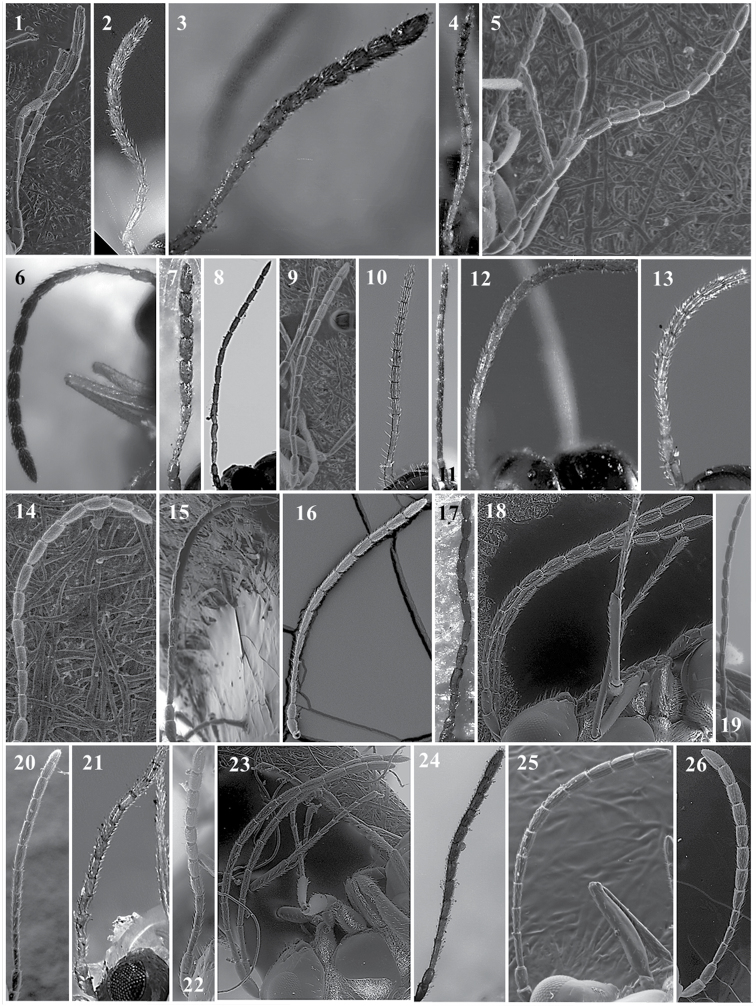
Alloxysta antennae. A.fracticornis (1); A.fuscipes (2); A.glebaria (3); A.halterata (4); A.hansoni (5); A.hendrickxi (6); A.heptatoma (7); A.japonicus (8); A.kovilovica (9); A.lachni (10); A.leunisii (11); A.longipennis (12); A.longiventris (13); A.luismii (14); A.macrophadnus (15); A.mara (16); A.marshalliana (17); A.medinae (18); A.mexicana (19); A.melanogaster (20); A.minuscula (21); A.mullensis (22); A.nepalica (23); A.nigricans (24); A.nigrita (25); A.nipona (26).